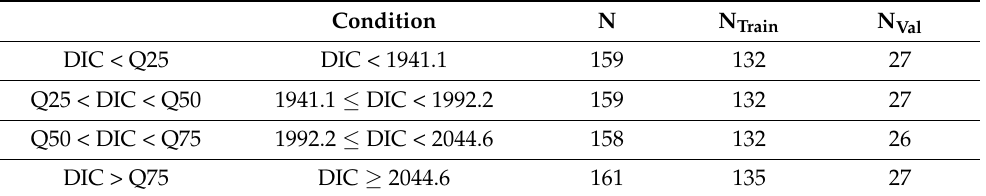
Table A2. Data distribution for the NN showing the total number of data (N), the number of data for training (N Train ) and for validation (N Val ) according to the 25%, 50%, 75% quantiles (Q25, Q50, Q75) of the DIC. The corresponding values of DIC are indicated in µ mol kg − 1 .